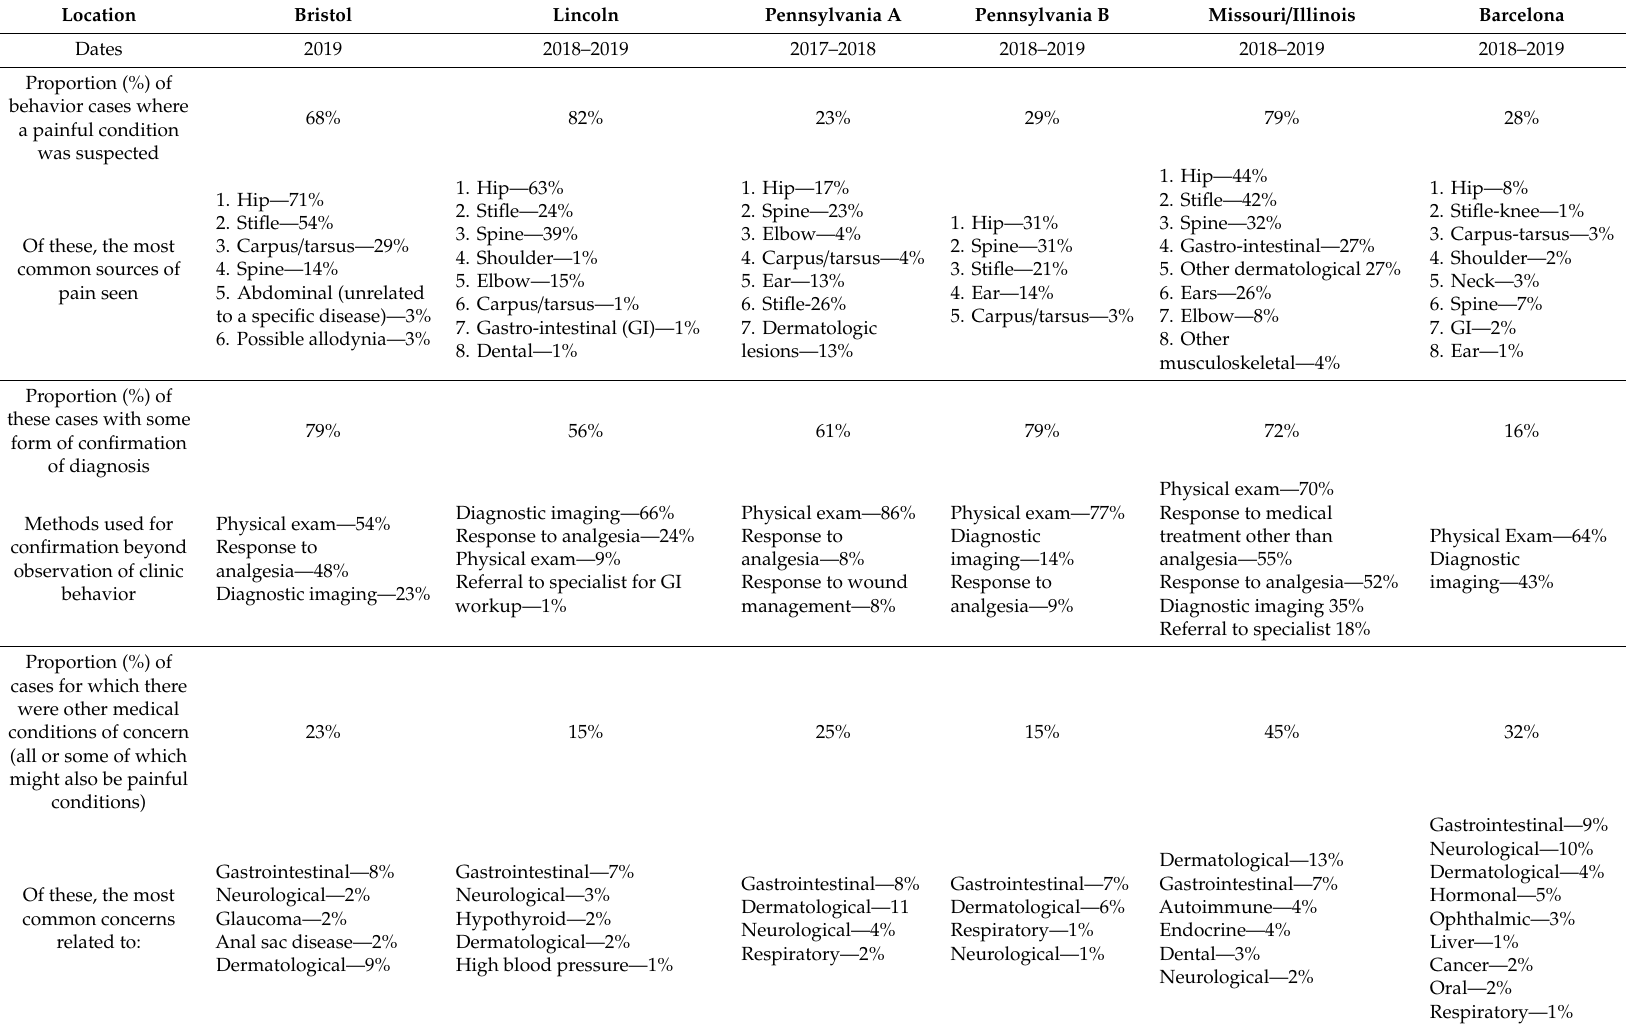
Table 1. Prevalence of pain-related behavior problems in dogs seen in various referral clinics of the authors.